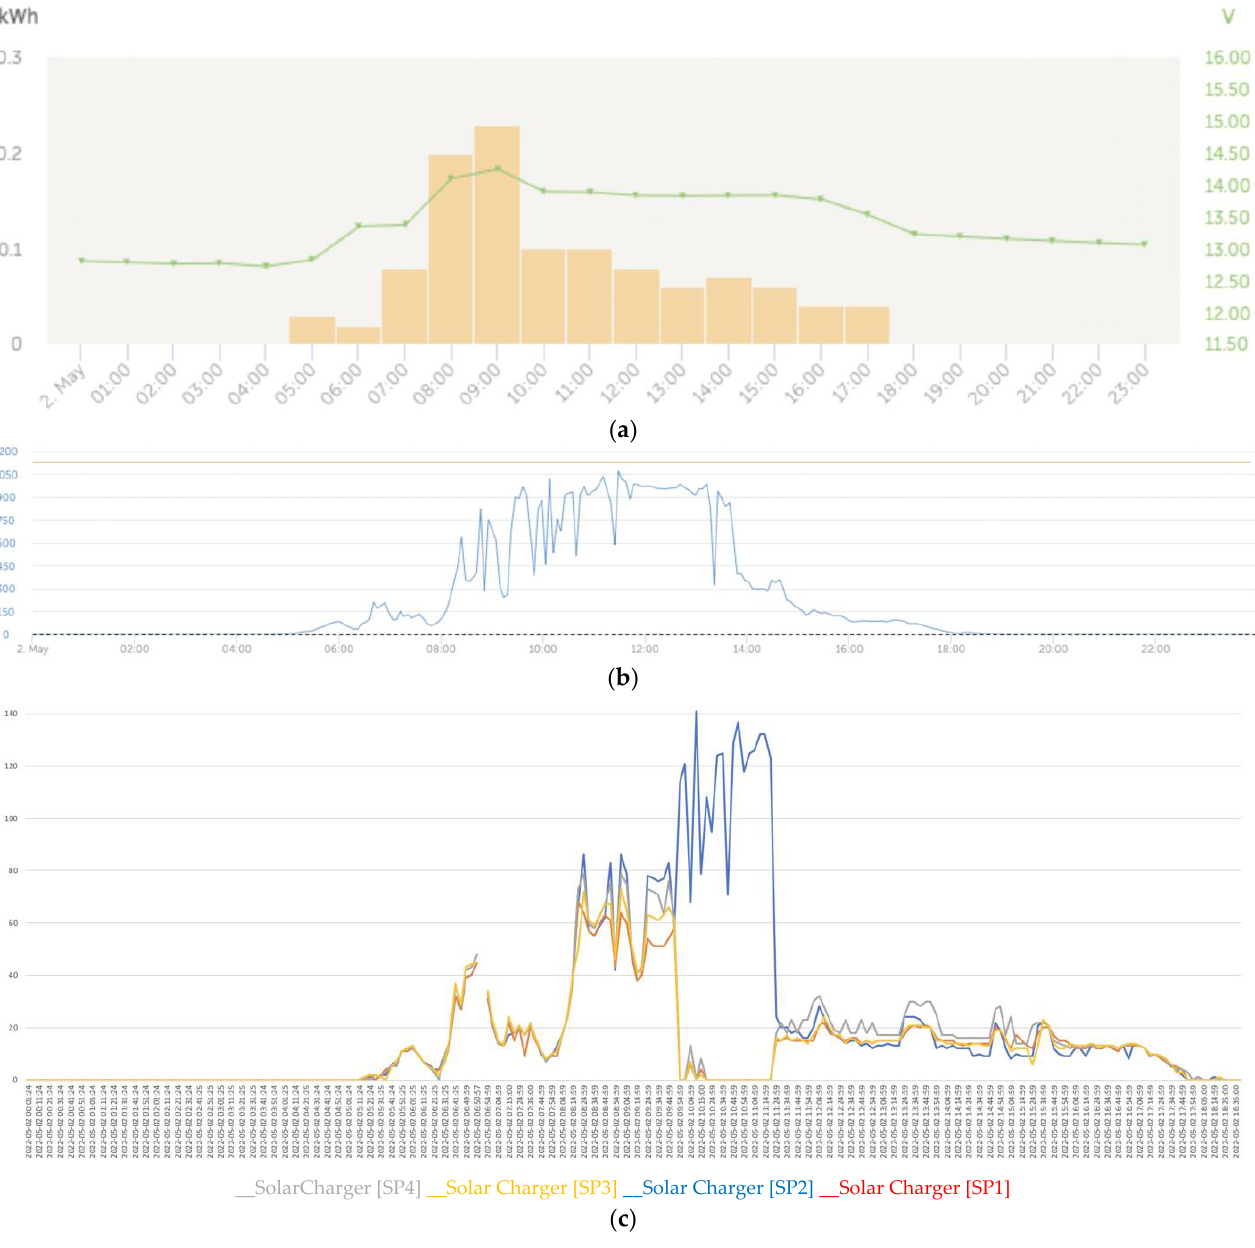
Figure 20. ( a ) Daily charge phases: initial, absorption, and flotation (2 May). ( b ) Irradiance (2 May). ( c ) Deviation trend comparative PV power data series analysis due to partial shading (2 May).